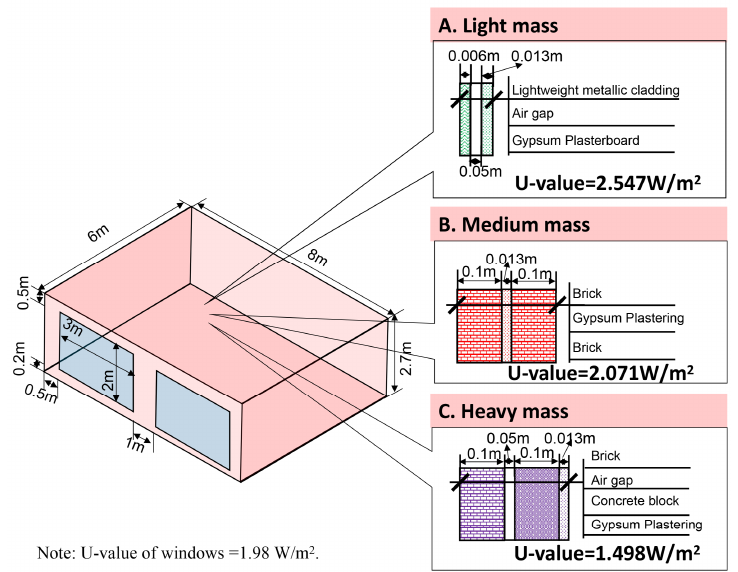
Figure 8. Geometry of BESTEST case 600 in the EnergyPlus